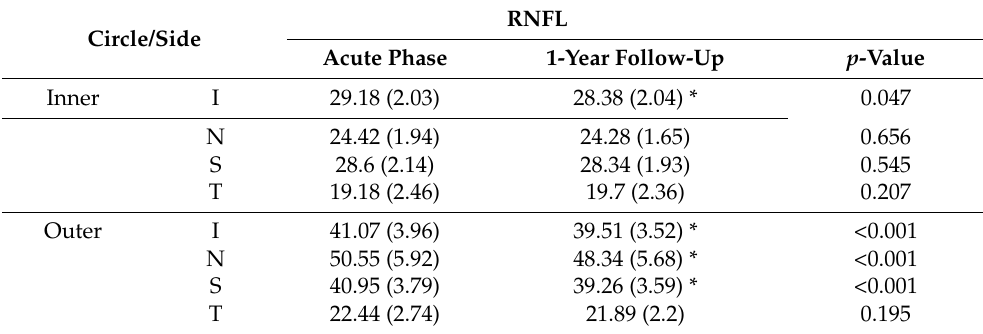
Table 2. Comparison of RNFL thickness between the acute phase and 1-year follow-up.